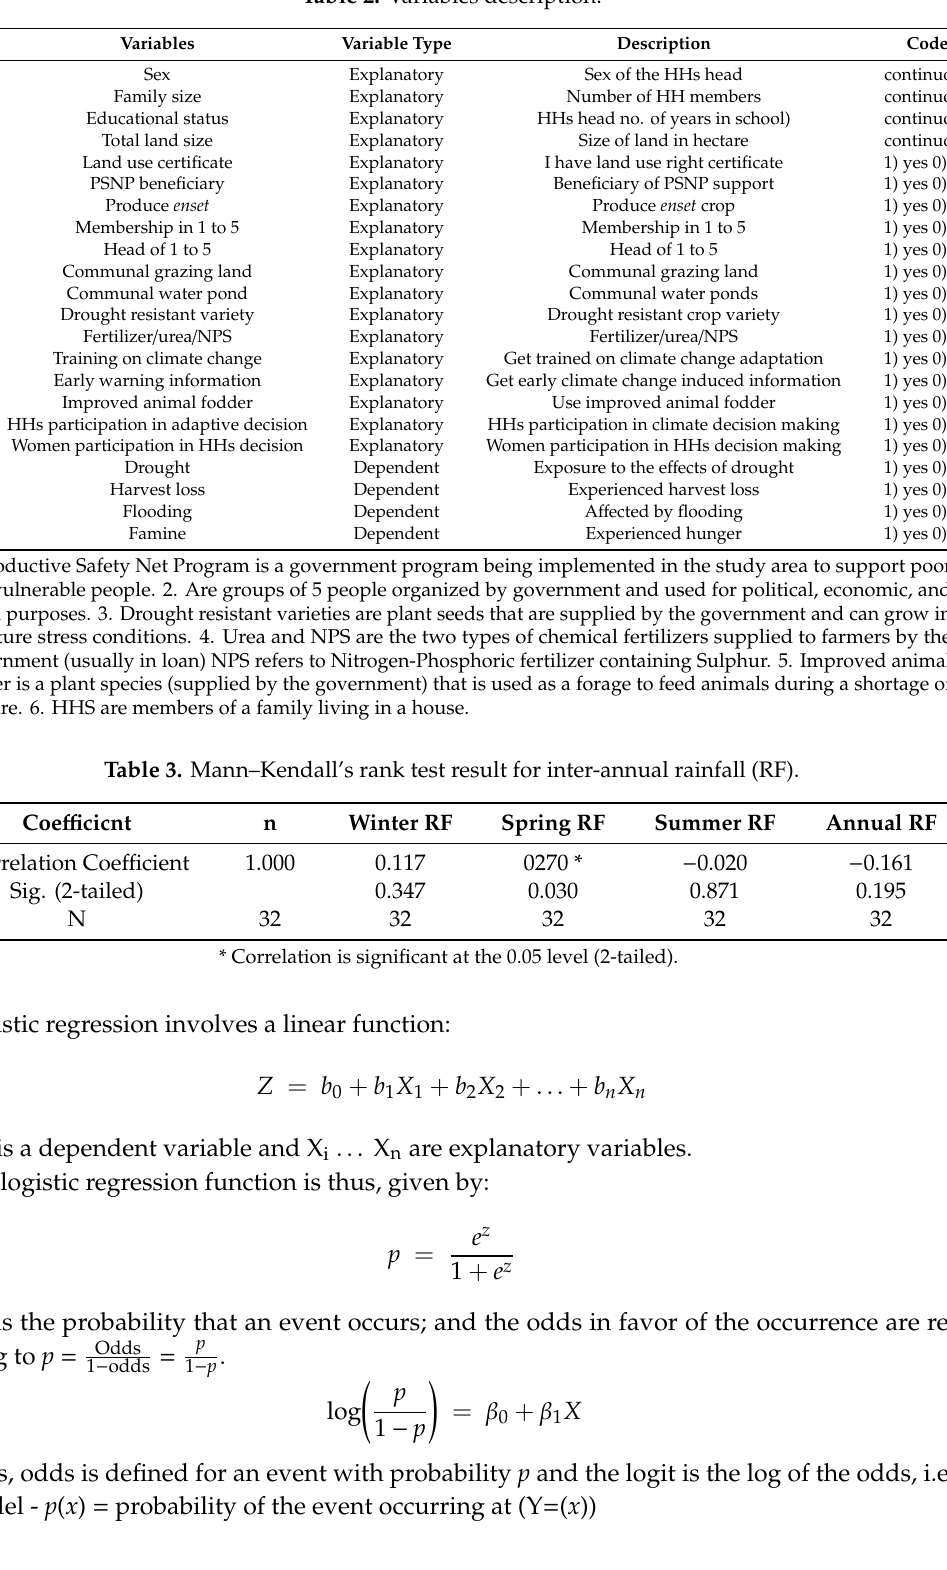
Table 2. Variables description.